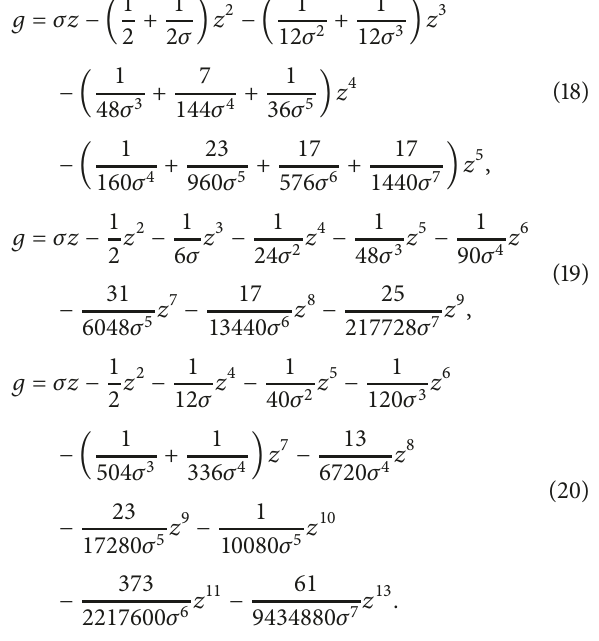
diffusion flux distribution for ℎ(𝑧) = 1 − 𝑧 and 𝑘(𝑧) = 𝑧, 𝑧 2 , 𝑧 3 . The results are illustrated in Figure 4. Figure 4 indicates that the diffusion flux decreases with the decrease of 𝑘(𝑧)